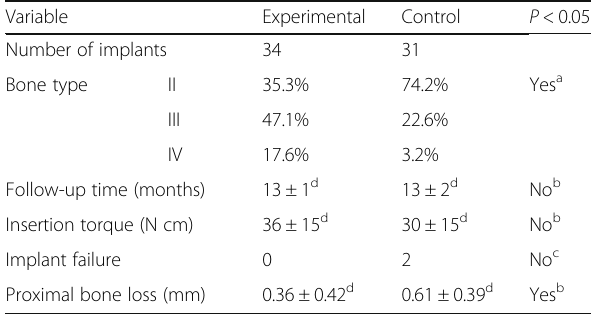
Table 3 Outcomes of experimental and control